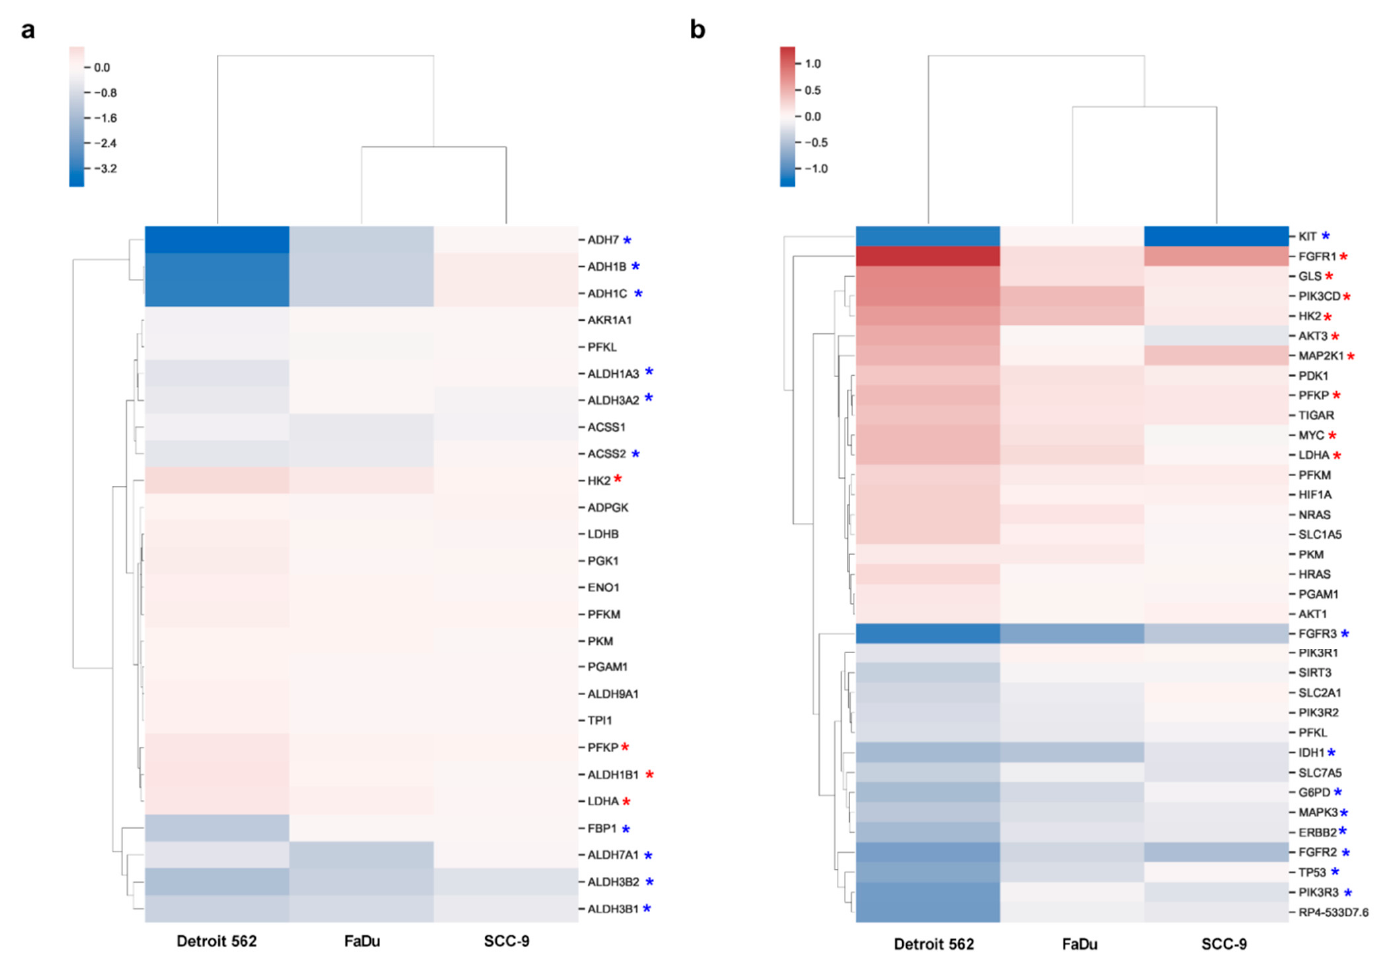
Figure 5. Heat maps of mRNA-sequencing results showing genes participating in KEGG pathway hsa00010, glycolysis / gluconeogenesis ( a ) or KEGG pathway hsa05230, central carbon metabolism in cancer ( b ). The color scale indicates log 2 fold changes between the HGF-stimulated sample and the unstimulated control. Upregulated genes are depicted in red, downregulated genes in blue colors, and unaltered genes in white. Only pathway-specific genes with p adj < 0.1 in Detroit 562 are shown. Red asterisks indicate genes with a log 2 fold change ≥ 0.4, blue asterisks indicate genes with a log 2 fold change ≤ − 0.4.